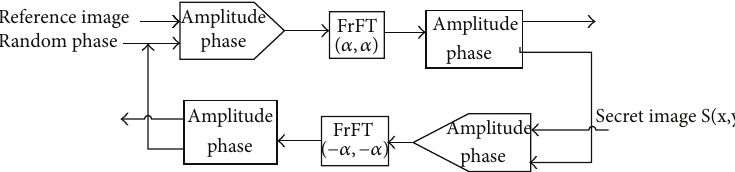
Figure 2: Flow chart of phase retrieval algorithm (adapted from Zhou et al.